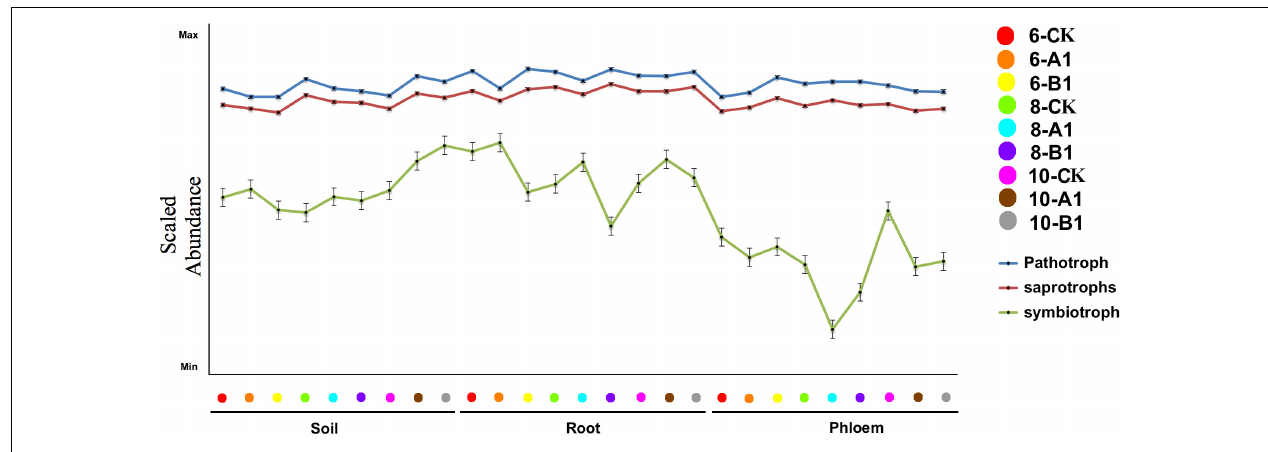
FIGURE 9 | Abundance of trophic groups in the fungal community across different samples. The vertical represents the Log10 transformation of the sample stages.